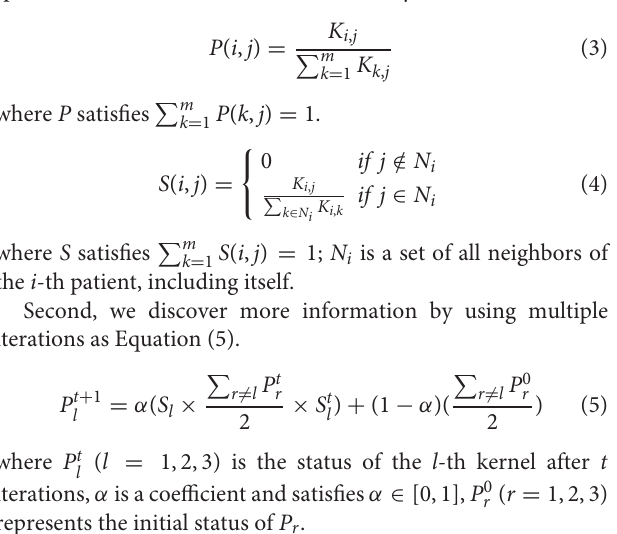
TABLE 1 | Description of three datasets from TCGA.